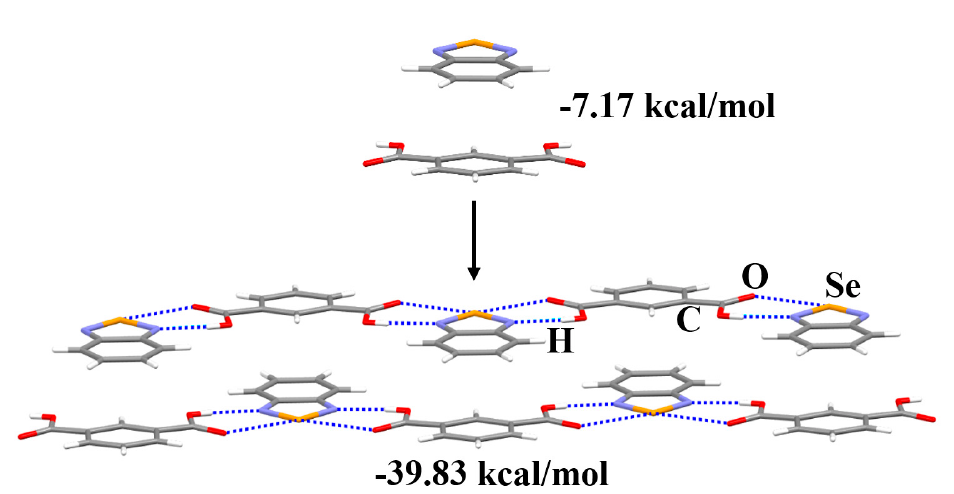
Figure 5. The interaction energies of one pair of π -stacked dimers and five pairs of π -stacked dimers connected by heterosynthon III in cocrystal 1 .